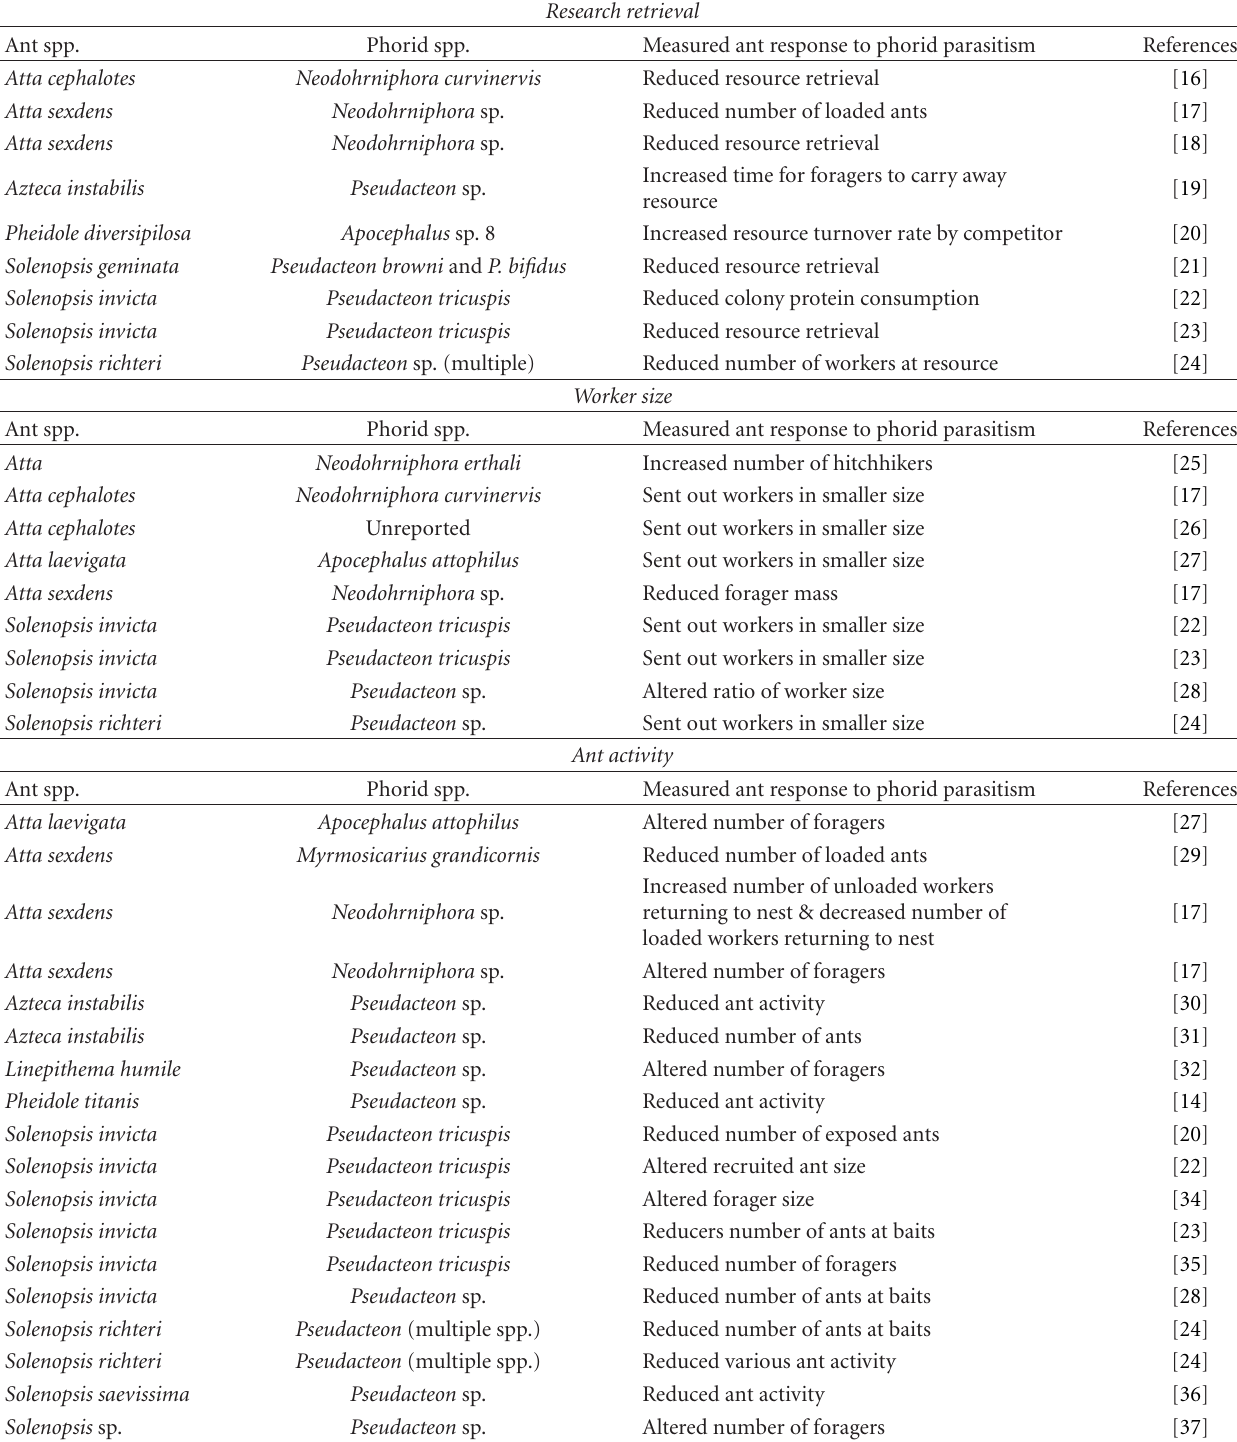
Table 1: Ant response to phorid